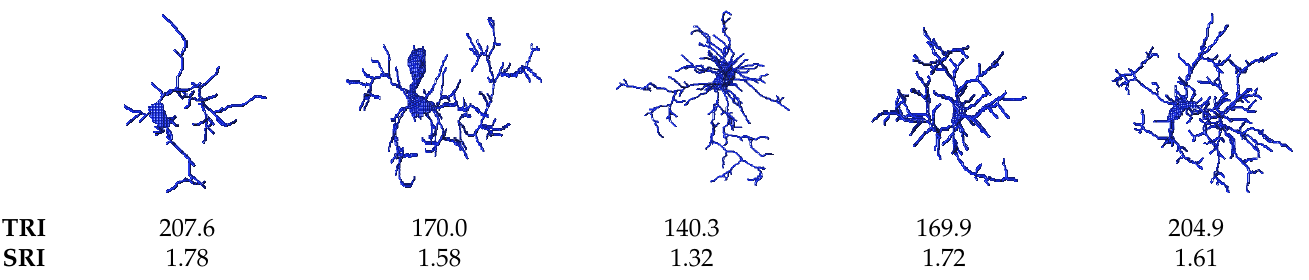
Figure 11. Examples of the TRI and SRI measures with different microglia.